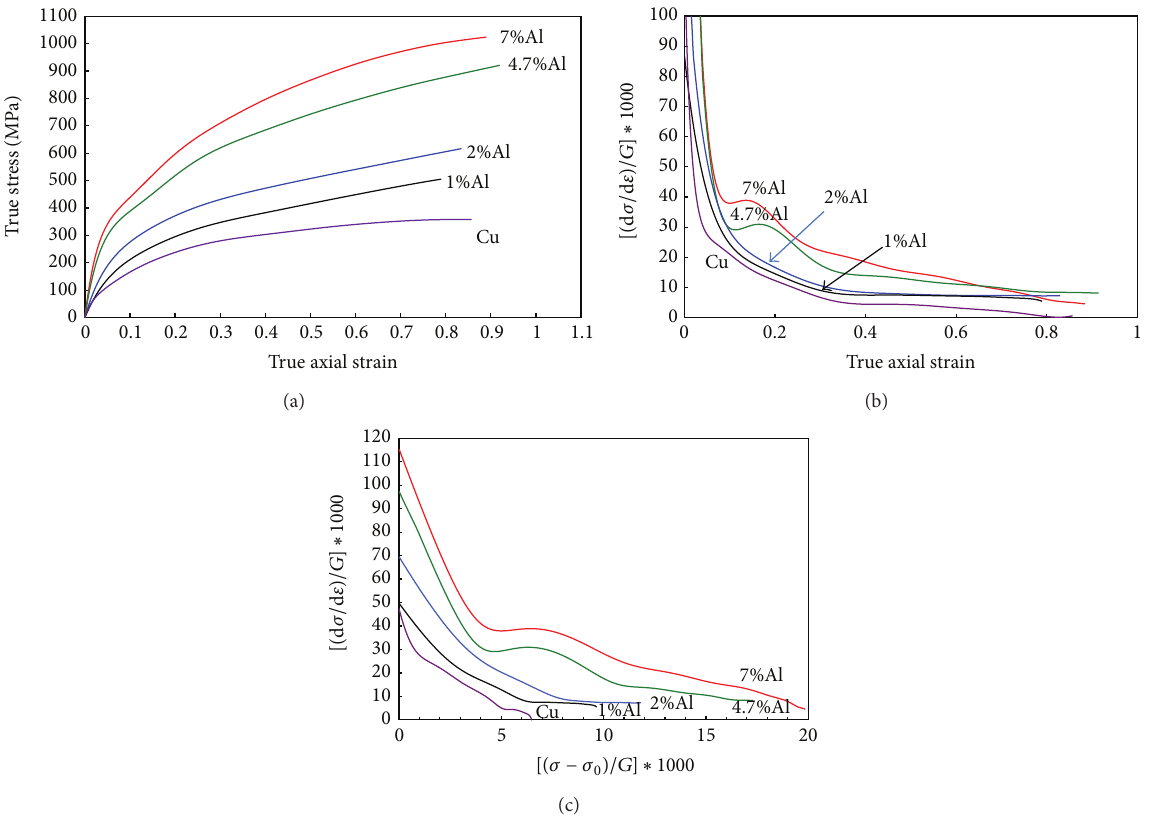
Figure 3: (a) True stress-true strain response for all materials with an average grain size of 70 𝜇 m, tested in plane strain compression. Normalized strain hardening rate versus true strain in (b) and versus normalized stress parameter in (c) for all materials displayed in part